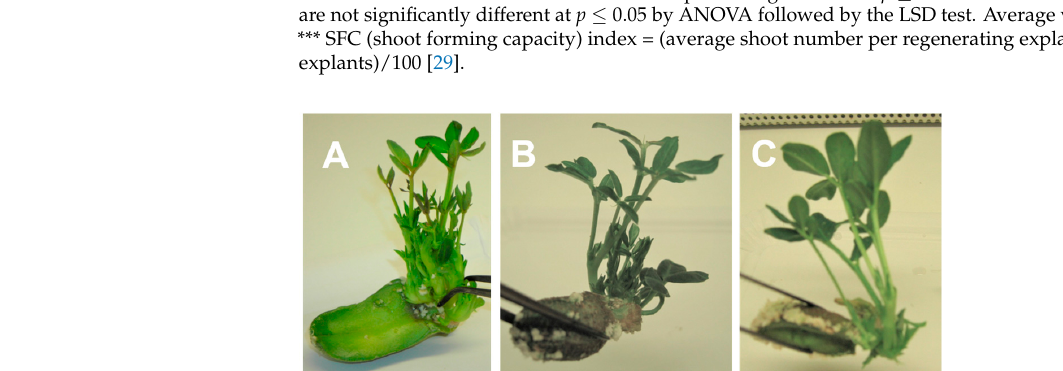
Table 5. De novo regeneration of Arachis hypogaea L. varieties, NC7, 7 × 77, and Com74, from de-